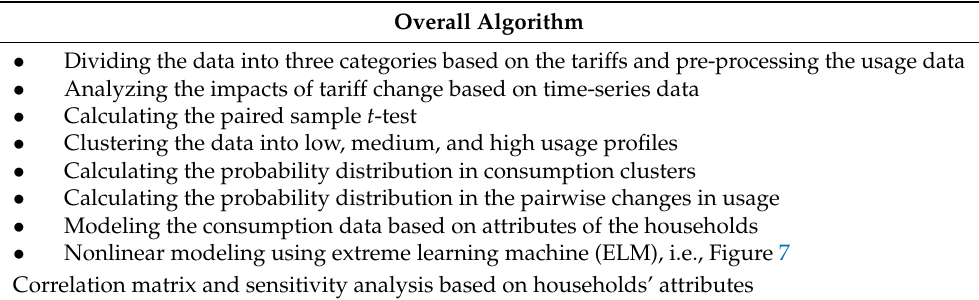
Table 2. Steps to analyze the impacts of tariffs on consumption. Overall Algorithm